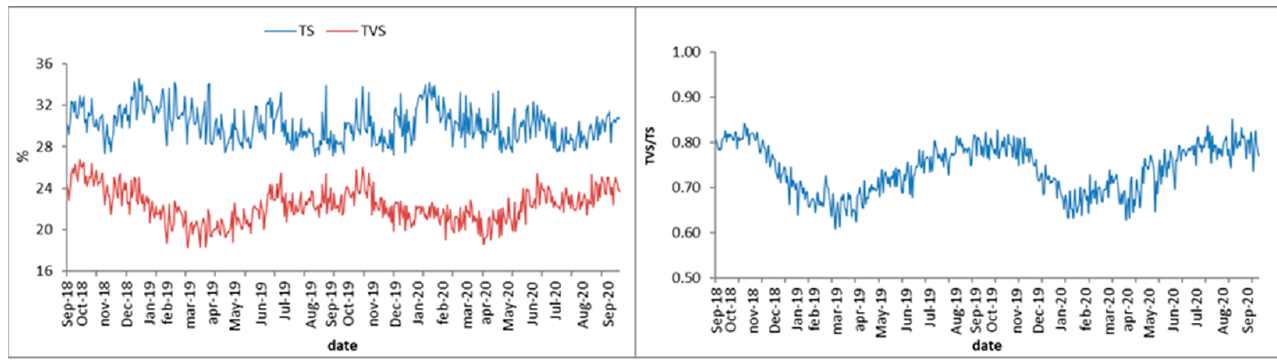
Figure 2. pH variation of pretreated SC ‐ OFMSW from September 2018 to September 2020. A similar seasonal variation is visible in the TVS trend and TVS/TS ratio trend (Figure 3).